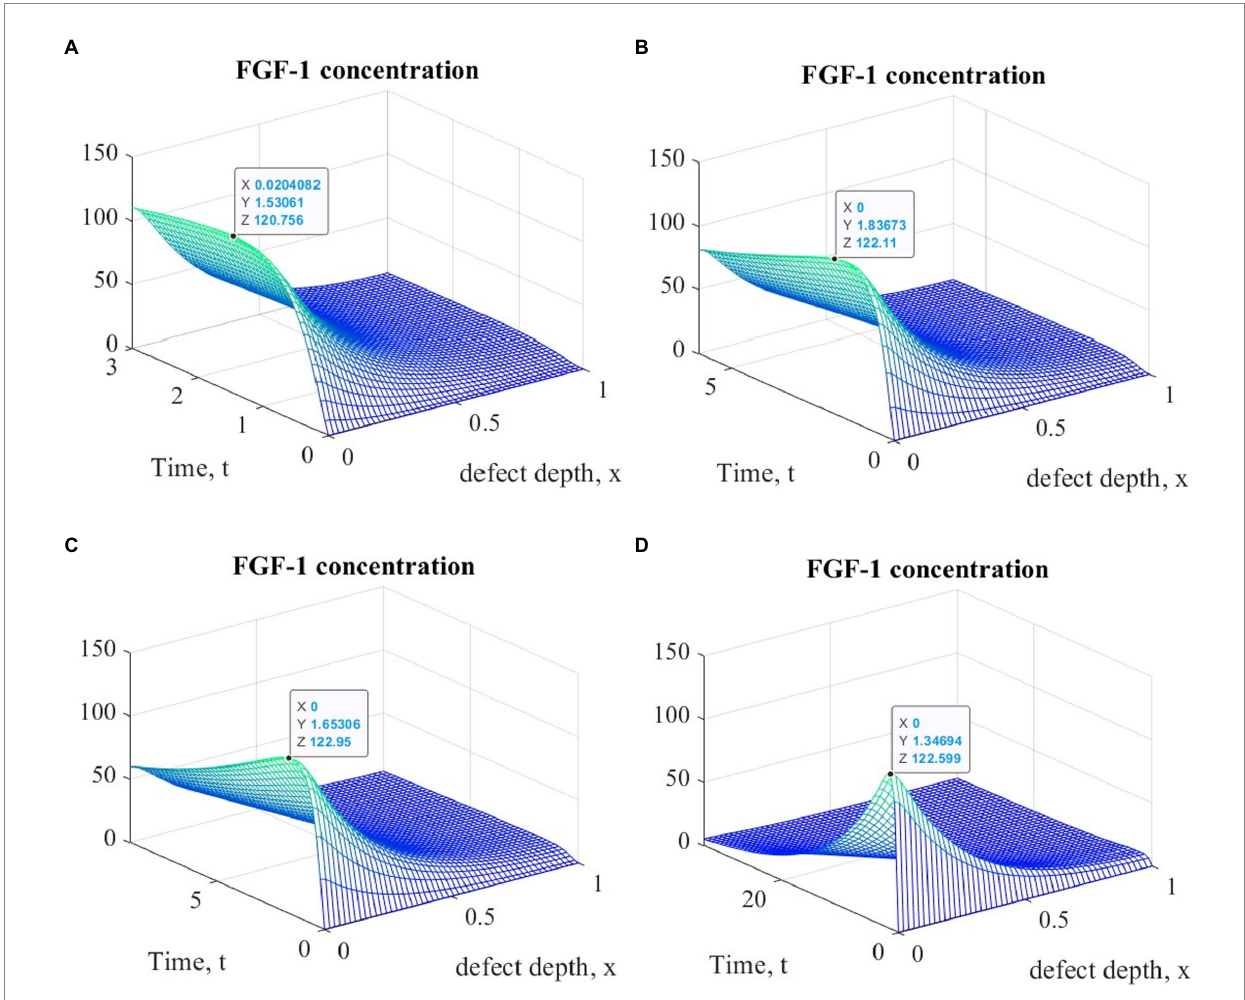
FIGURE 6 Graphs of changes in FGF-1 concentration at different time points during the implementation of ACIT with mechanical stimulation with a time delay